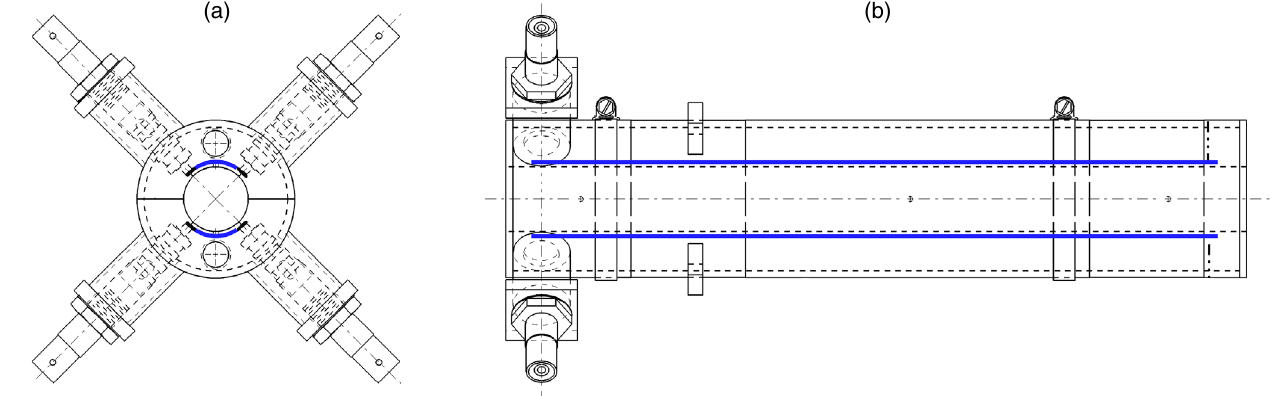
FIG. 13. (a) Transverse and (b) longitudinal views of the stripline kicker used in the FONT system [28]. The two conducting strips are shown in blue: they are linked together at their right-hand ends in